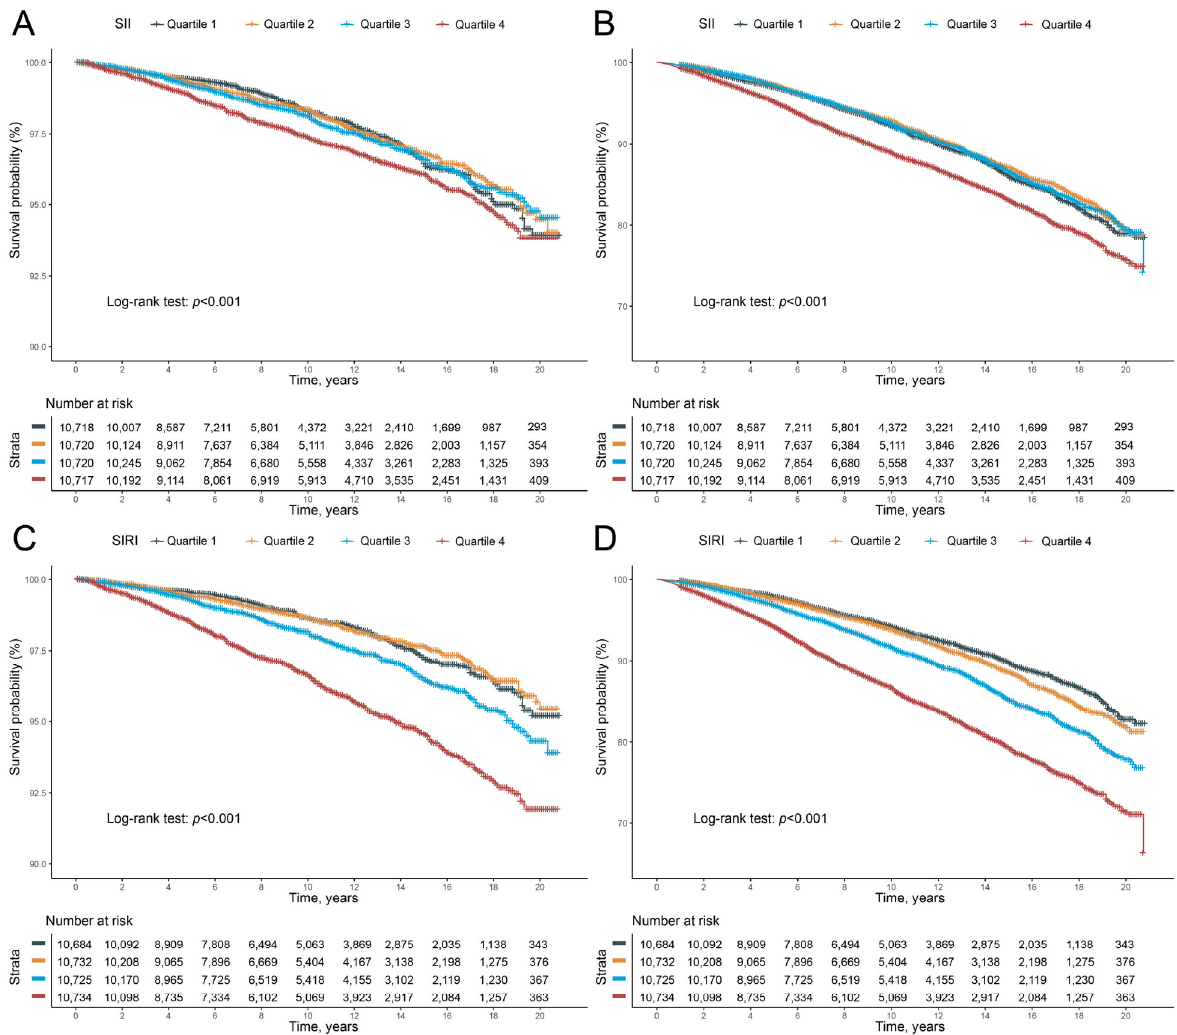
Figure 2. ( A , B ) The Kaplan ‐ Meier curves for 20 ‐ year occurrence of ( A ) cardiovascular and ( B ) all ‐ cause mortality, by quartiles of SII. ( C , D ) The Kaplan ‐ Meier curves for 20 ‐ year occurrence of ( C ) cardiovascular and ( D ) all ‐ cause mortality, by quartiles of SIRI. Table 3. HRs (95% Cis) of cardiovascular diseases and all ‐ cause mortalities according to quartiles of SII among the general adult population in NHANES, 1999–2018.